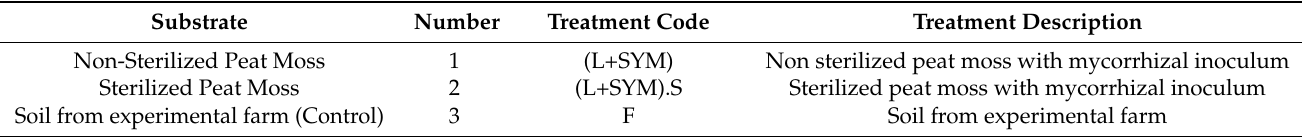
Table 1. Treatments used during the experiment per